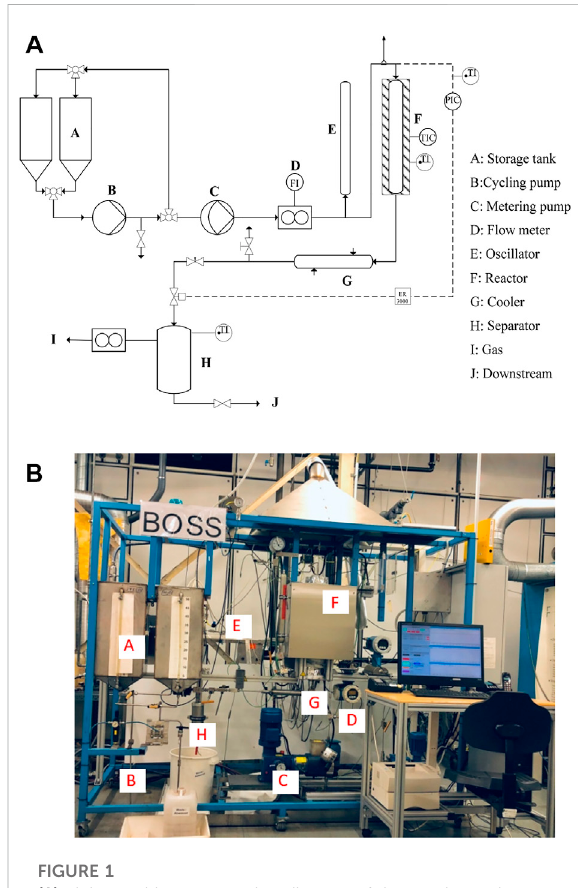
FIGURE 1 (A) piping and instrumentation diagram of the continuously operated plant (B) picture of the experimental